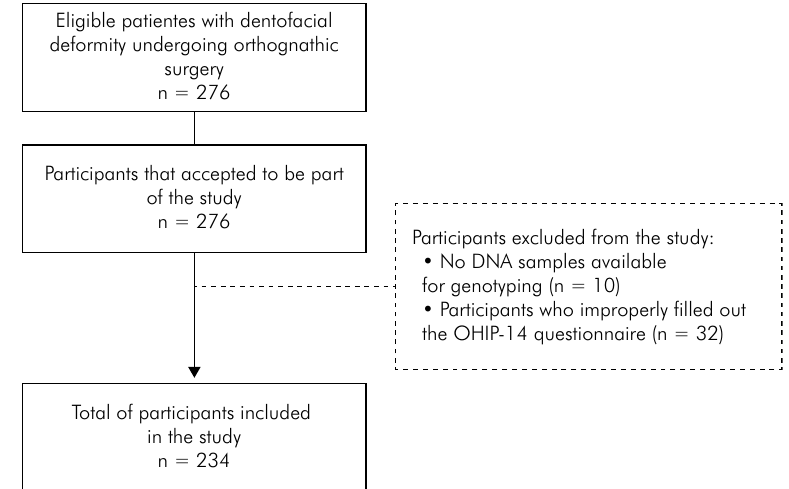
Figure. Flowchart demonstrating the study population selection